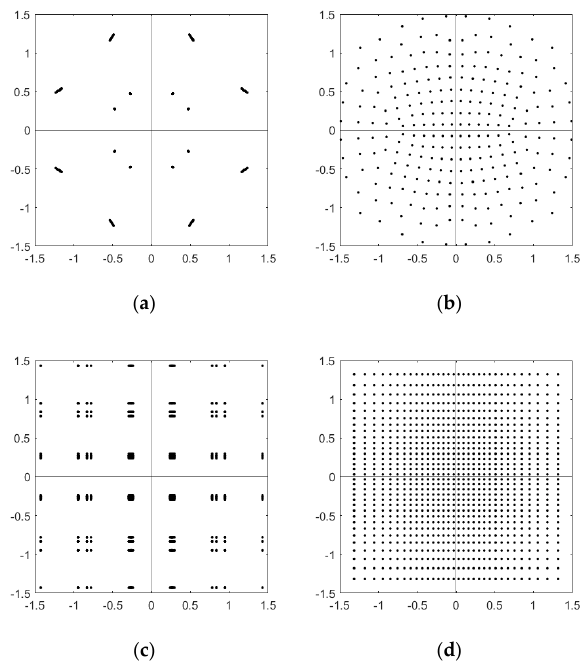
Figure 1. 2D-256NUC and 1D-1024NUC designed for di ff erent CRs in ATSC 3.0. ( a ) 2D-256NUC designed for CR = 3 / 15; ( b ) 2D-256NUC designed for CR = 13 / 15; ( c ) 1D-1024NUC designed for CR = 3 / 15; ( d ) 1D-1024NUC designed for CR = 13 /